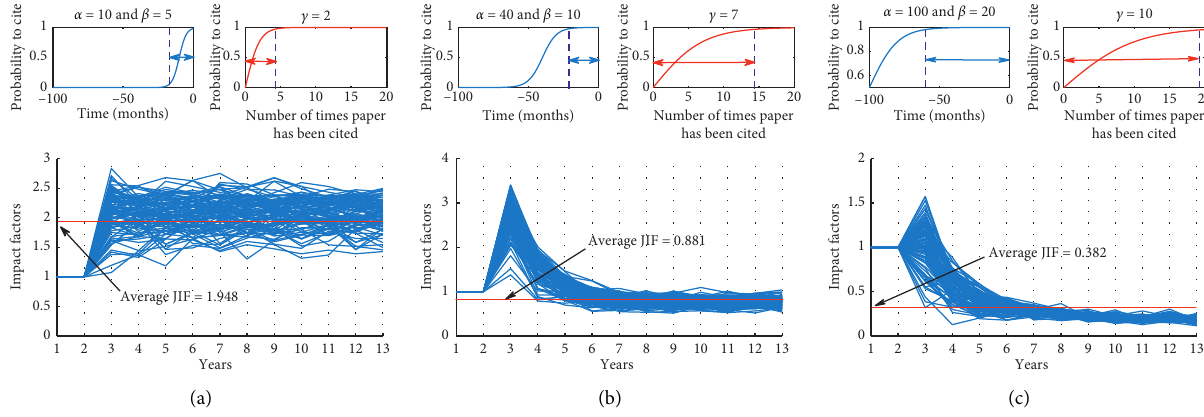
� 10 and N � 30. ( baseline ) ( baseline )